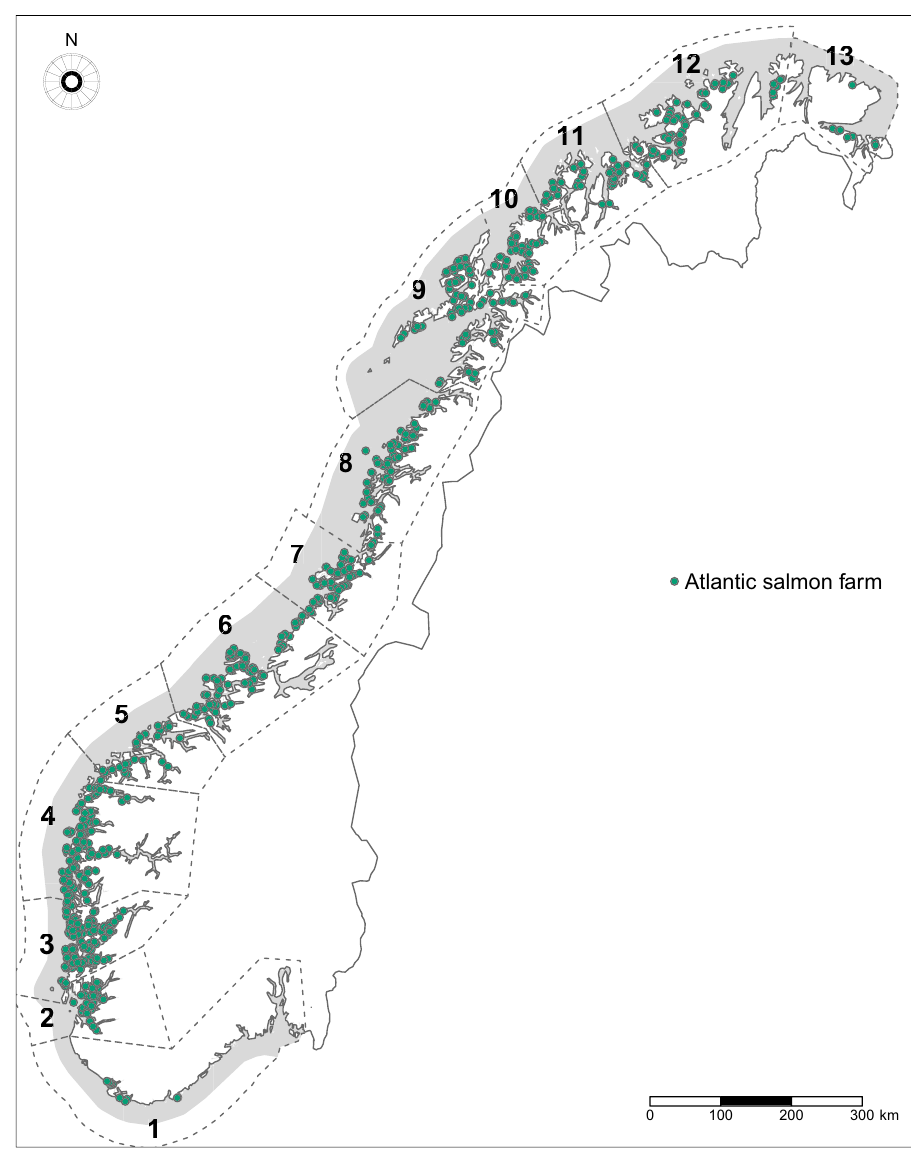
Figure 6. Geographical location of Atlantic salmon farms and production zones in Norway. The map shows all commercial farms for the purpose of food production registered between January 2014 and December 2019. The regions delimited by dashed lines represent the production zones 1–13. This map was generated in R, using the R packages sf 78 (version 0.9-7; https:// cran.r- proje ct. org/ web/ packa ges/ sf/ sf. pdf) and tmap 79 (version 3.3-1; https:// cran.r- proje ct. org/ web/ packa ges/ tmap/ tmap.